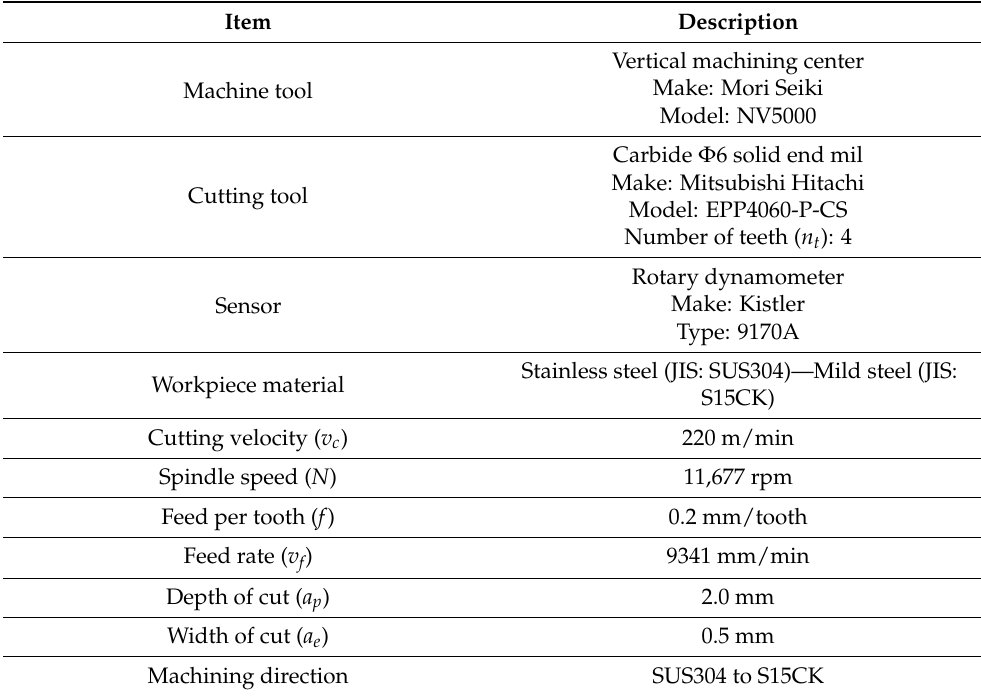
Table 4. Machining conditions for machining a multi-material workpiece.